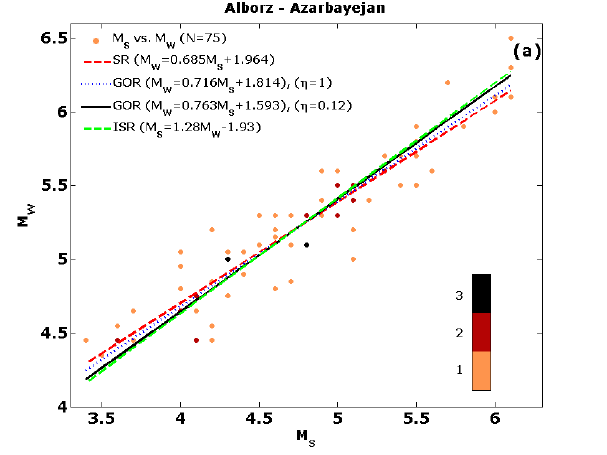
Figure 6 (clockwise from above left). M for major seismotectonic provinces in Iran (M as Figure 3.